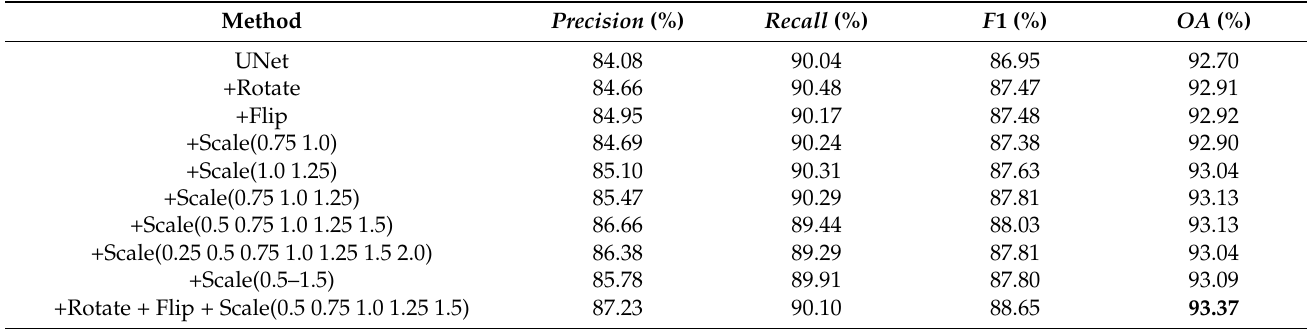
Table 3. The effects of data augmentation on segmentation